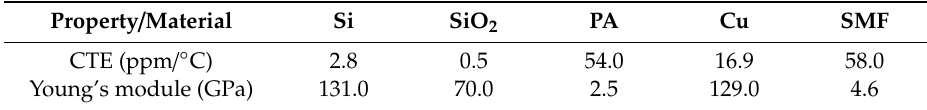
Figure 4. Package failure modes after TC test. ( a ) Pad delamination in the bottom of the TSV; ( b ) RDL crack near the UBM neck. Table 1. Material property related to the package.